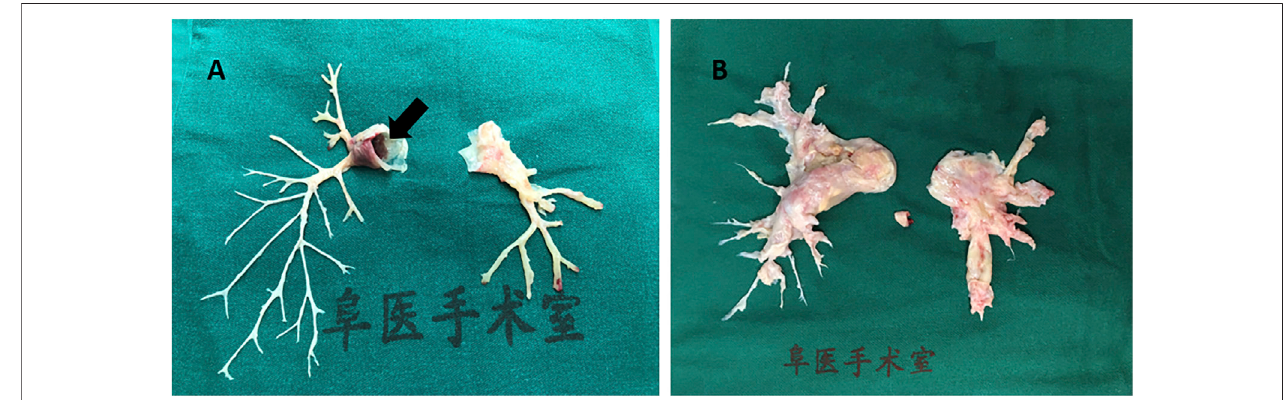
FIGURE 1 | Human pulmonary artery pathological specimen shows (A) in fl ammatory intima specimen accompanied with emboli in pulmonary artery main trunk (black arrow) taken from a patient of pulmonary vasculitis; (B) hyperplasia endothelial tissue from pulmonary endarterectomy operation in chronic thrombosis embolic pulmonary hypertension (CTEPH)